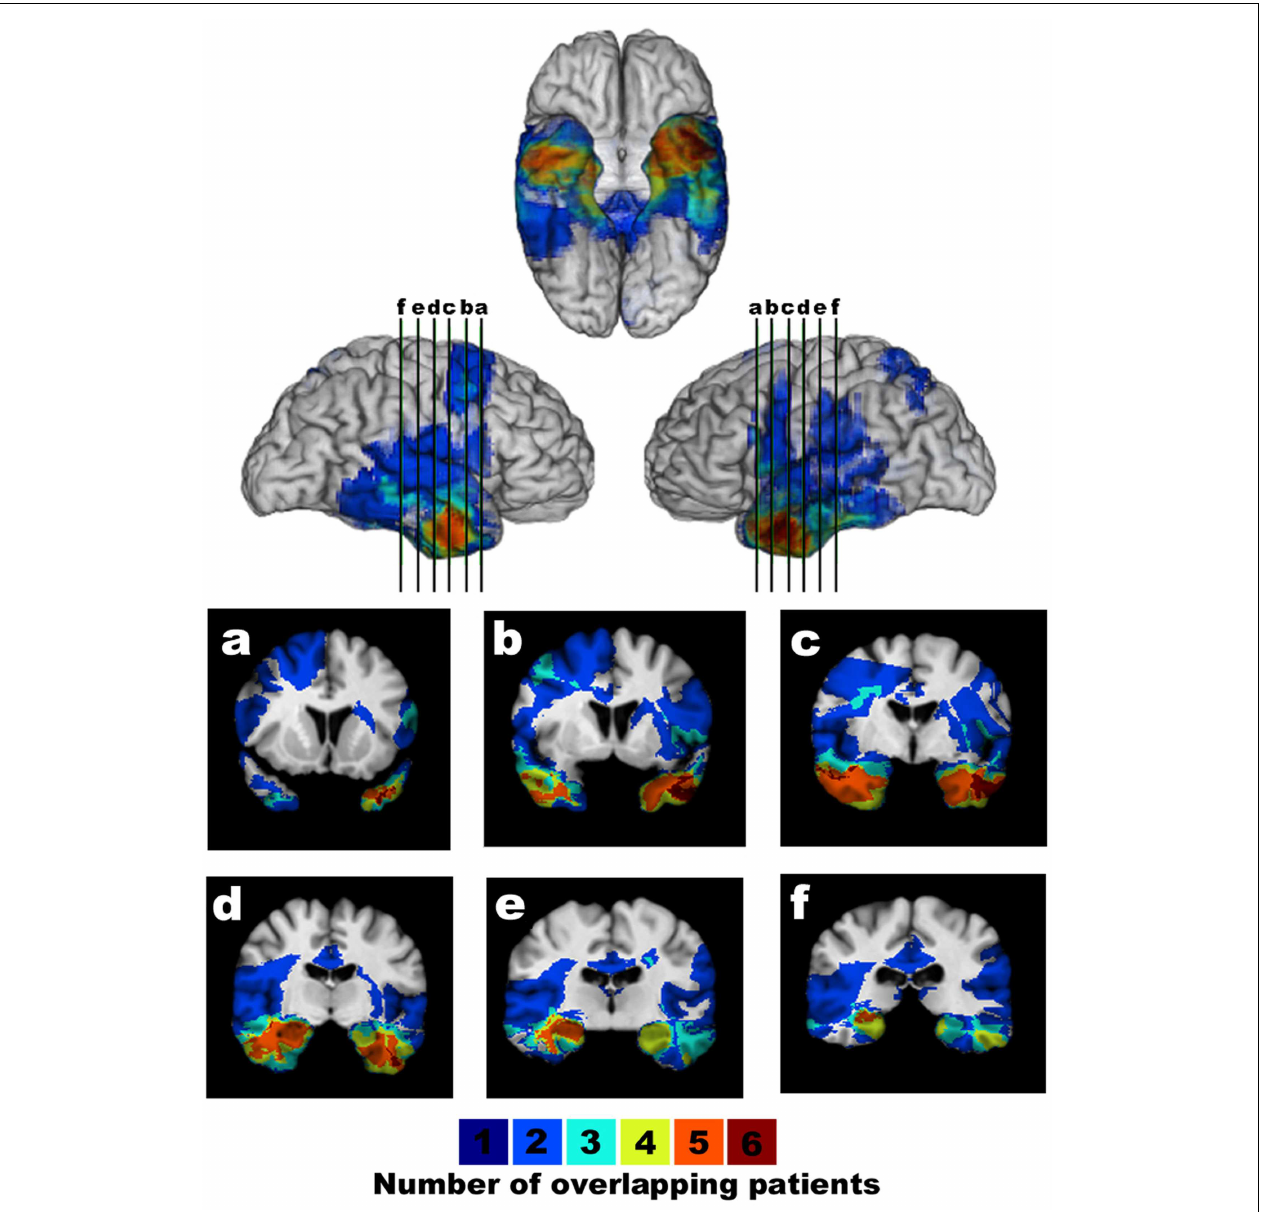
FIGURE 2 | Lesion overlap of brain damage comparison patients. The overlap map shows the lesions of BDC patients displayed in ventral/lateral views and coronal slices (a–f, with the right hemisphere on the left in the coronal views).The color bar indicates the number of overlapping lesions per